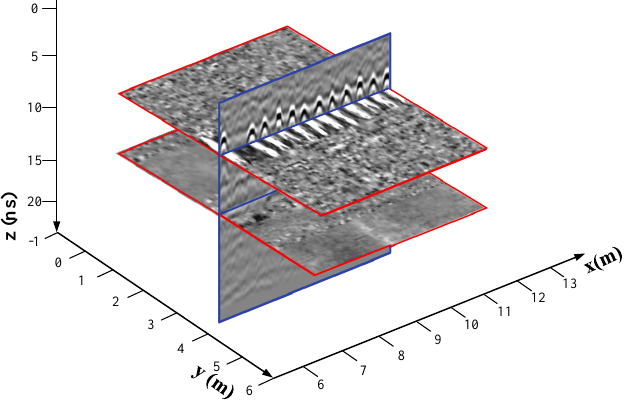
Figure 4. An example of B − scan and Top − scan